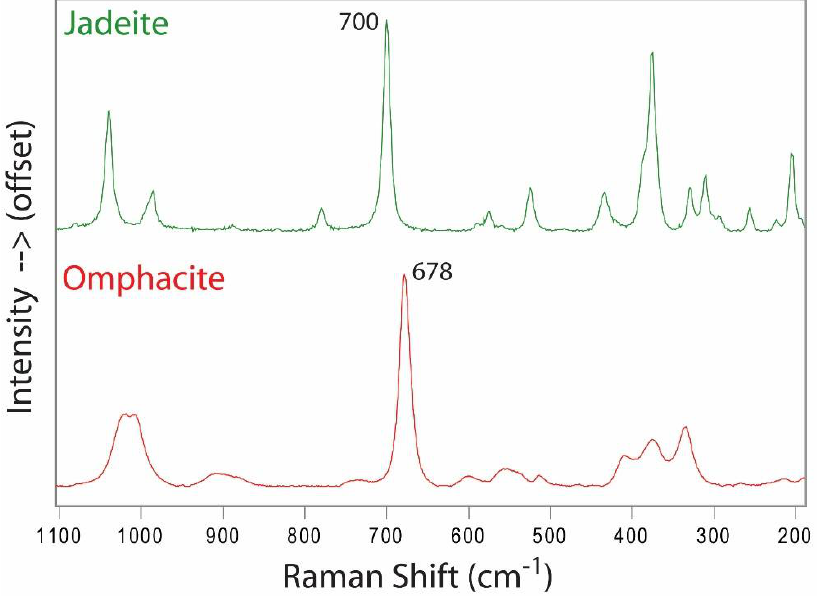
Figure 26. Raman spectra collected with a 514 nm laser reveal important differences between jade- ite and omphacite. Data from RRUFF database [58]. and omphacite. Data from RRUFF database